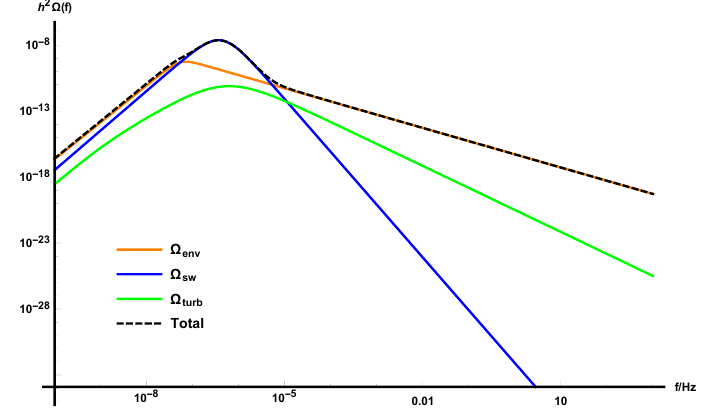
Figure 3 . The GWs spectrum or the energy density of the GWs produced from the (cid:12)rst order QCD phase transition by using the holographic QCD model.